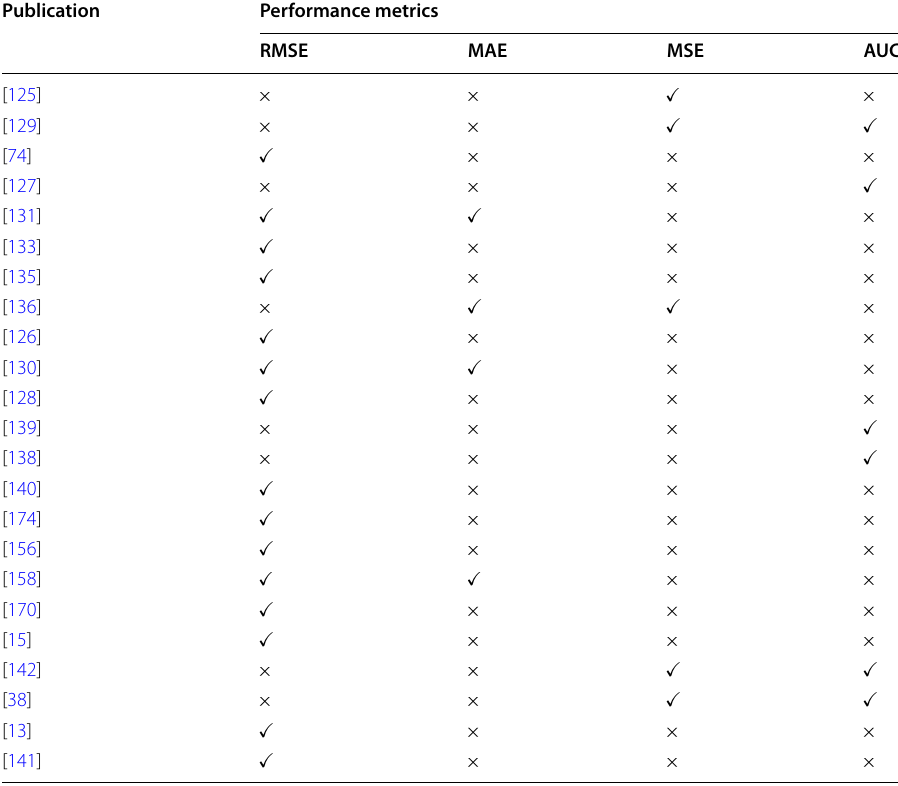
Table 3 Qualitative comparison between different missing data techniques in machine learning based on the performance metrics